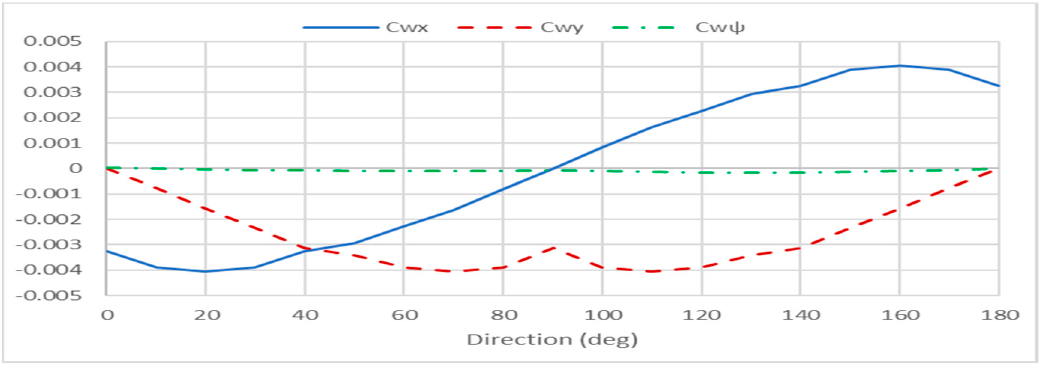
Figure 4. Wind load coefficients.